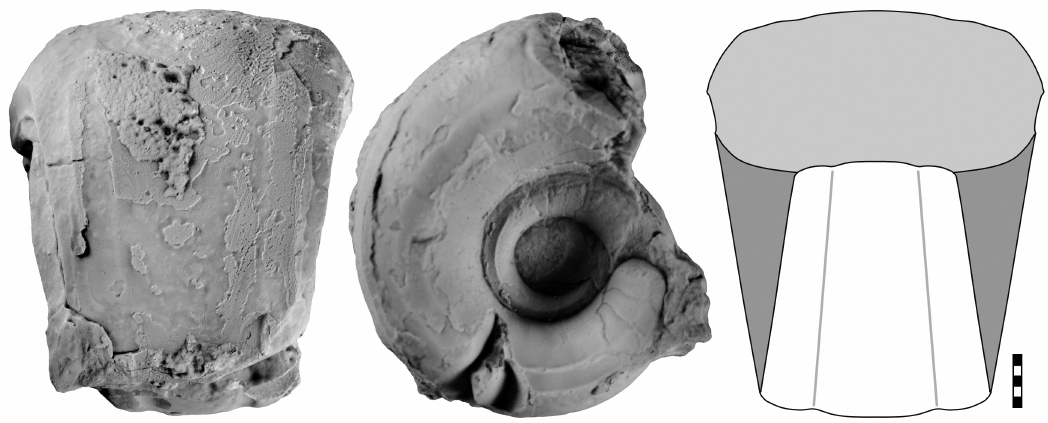
Fig. 20. Vestinautilus bicristatus sp. nov., holotype MB.C.30473 (Wendt & Kaufmann Coll.) from Oued Temertasset. Scale bar units = 1 mm.